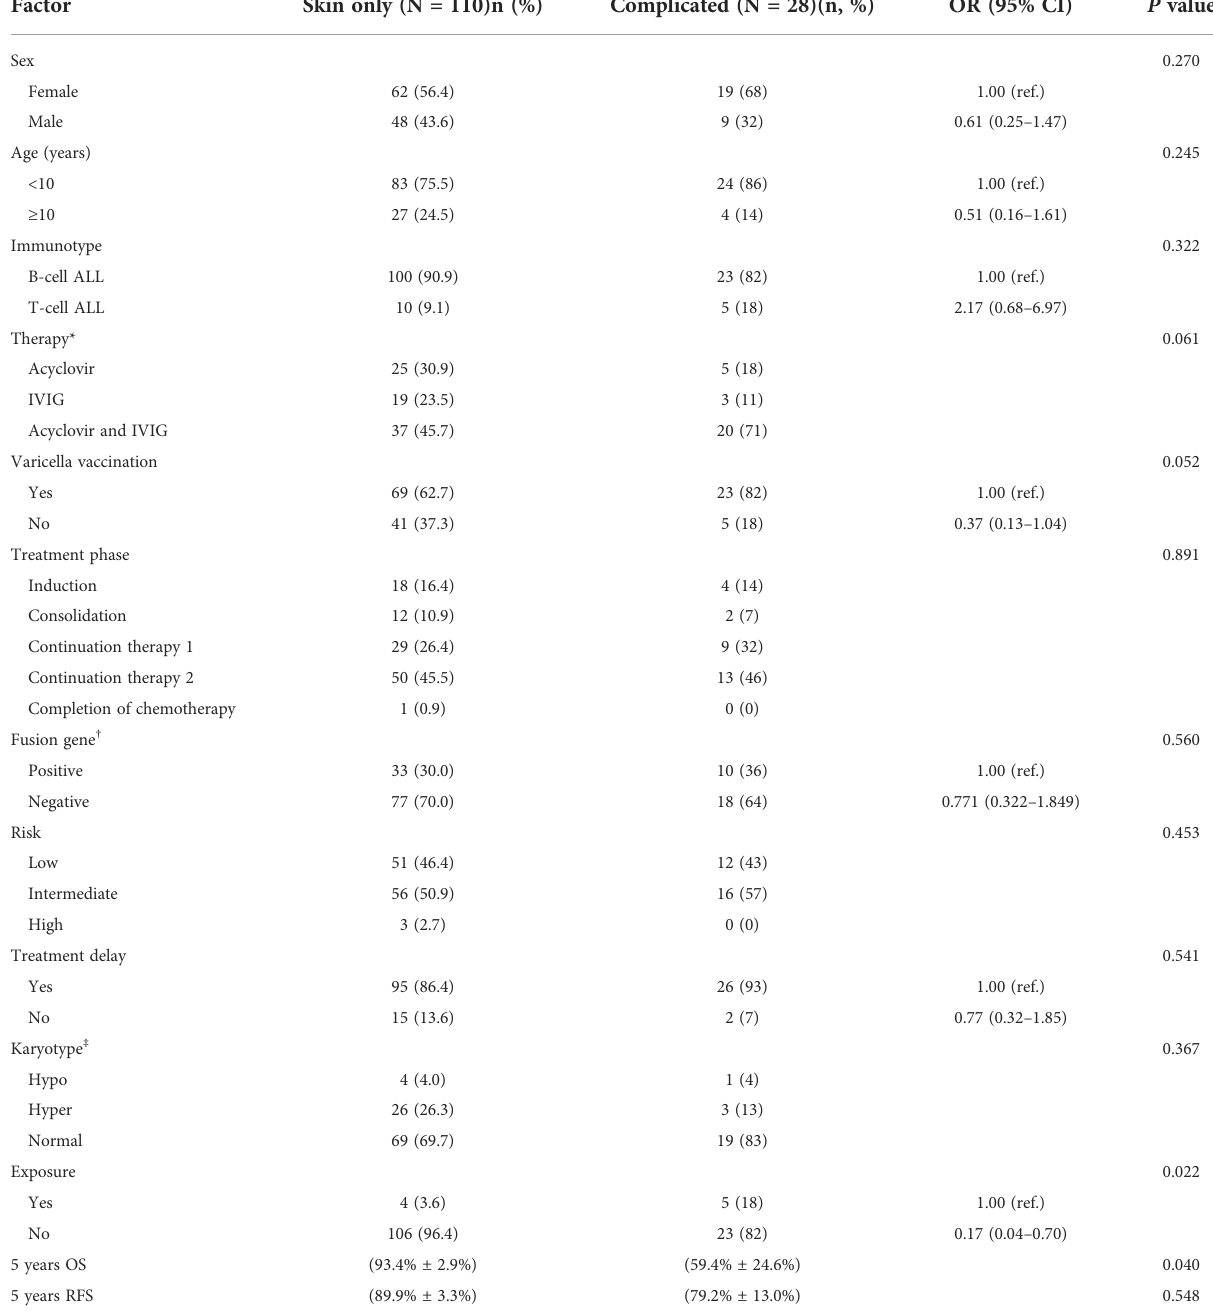
TABLE 2 Comparison of the clinical features of skin only and complicated varicella-zoster virus infection in children with acute lymphoblastic leukemia.